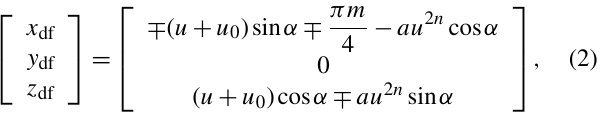
modification curve; u 0 is the distance between the parabola vertex position and the pitch line of the unmodified straight blade. Figure 1b is the sectional view of the shaping